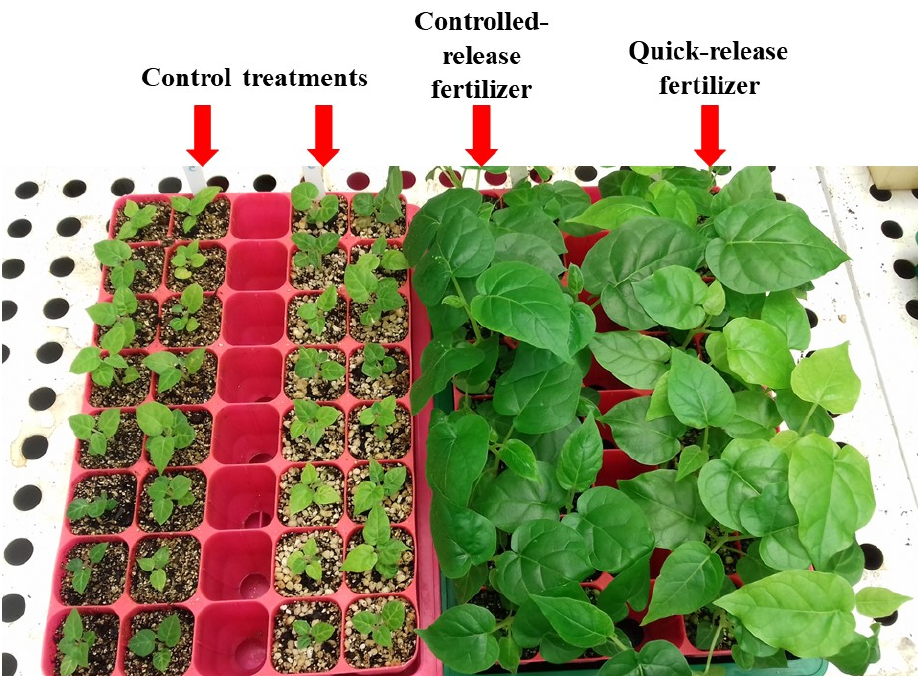
Figure 1. Effect of nutritional supplementation on plant growth during the acclimatization period (3 weeks after ex vitro transplantation).